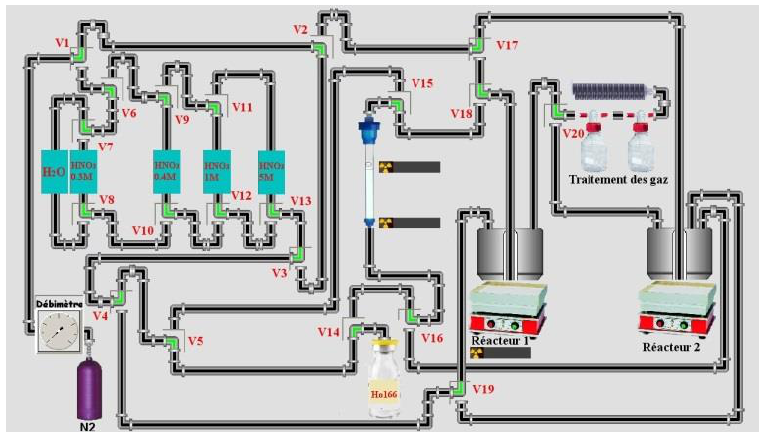
Figure 3. Remote control of Er/Ho separation.